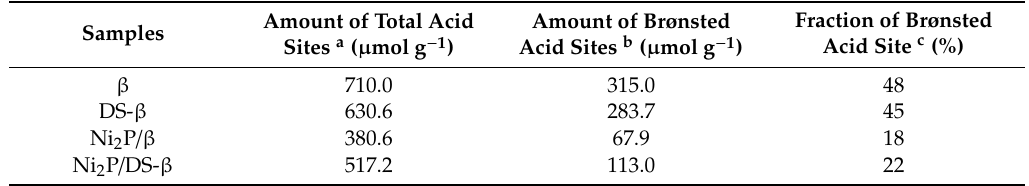
Table 2. Acidic properties of the β and DS- β zeolites.